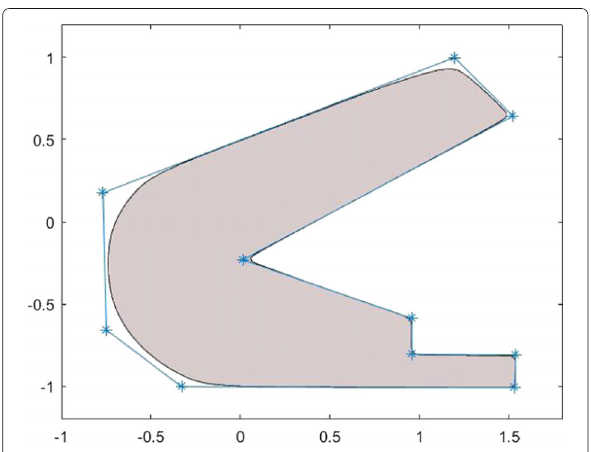
Fig. 7 A free-form 2D implicit area corresponding to a given polygon can be obtained by smoothing different vertices differently by using different smoothing parameter